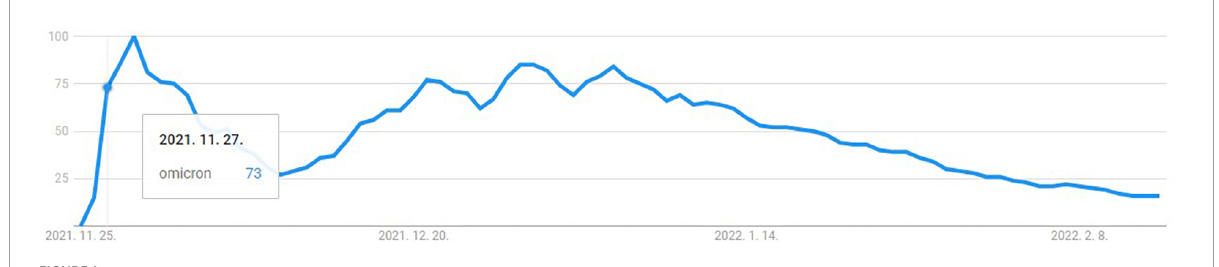
FIGURE1 Trend in the volume of keyword search related to the Omicron variant in South Korean news media (27 November 2021—14 February 2022).